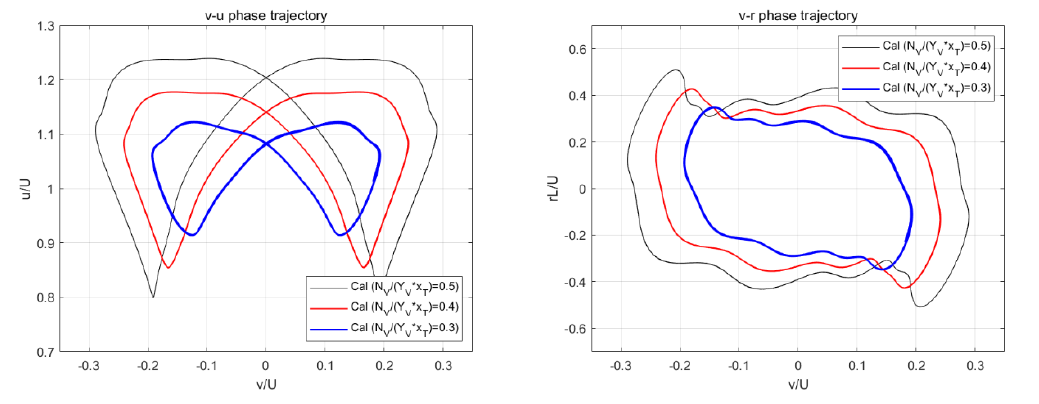
= 1.0). Figure 6. Phase trajectories of the towed vessel under various towing speed conditions ( 𝐿 𝐿⁄ = 1.0 T / L (cid:3021)